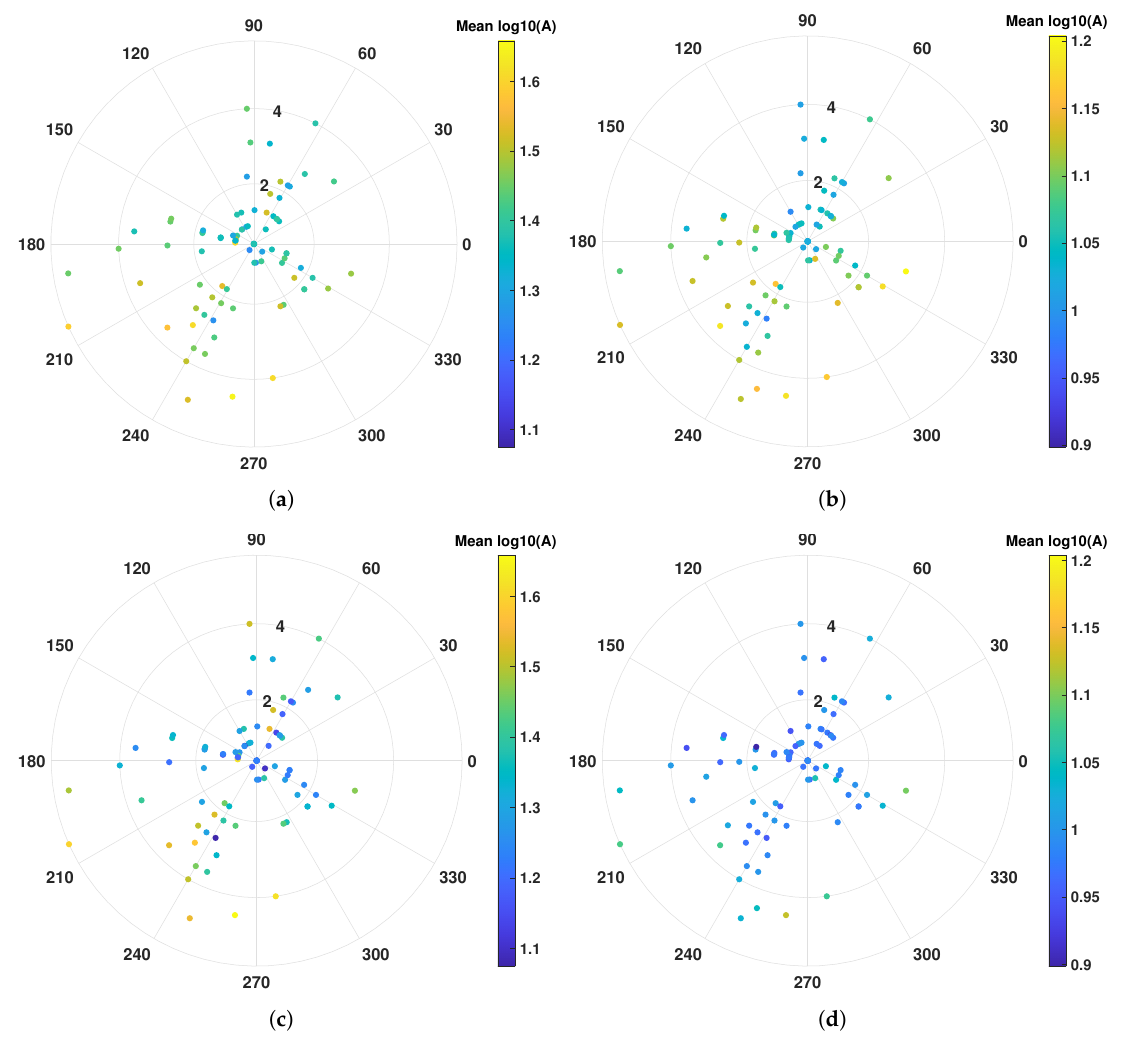
Figure 9. Amplitude in logarithmic scale (color bar) as a function of the wind direction (0° = North; 90° = East) and wind intensity (m/s; represented on the radius). Amplitude in VV and VH polarizations is represented, respectively, on the sand mask in the panels ( a , b ), and on the sea mask in the panels ( c , d ). A dependence of amplitude on the wind direction can be noticed both in the two masks and in the two polarization. In general, for both polarizations and both masks, high wind intensity is associated with high amplitude values. For some wind angle (i.e., 210°–240°), the dependence of the amplitude on the wind is more considerable.